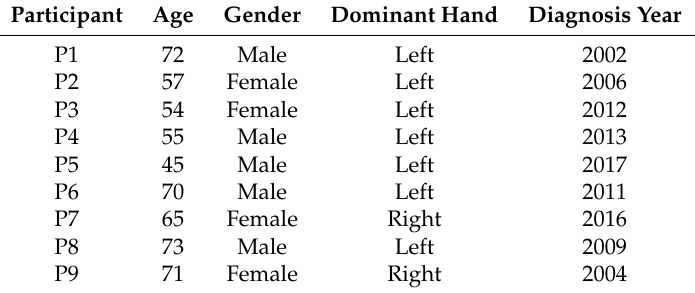
Table 1. Demographics and health status of